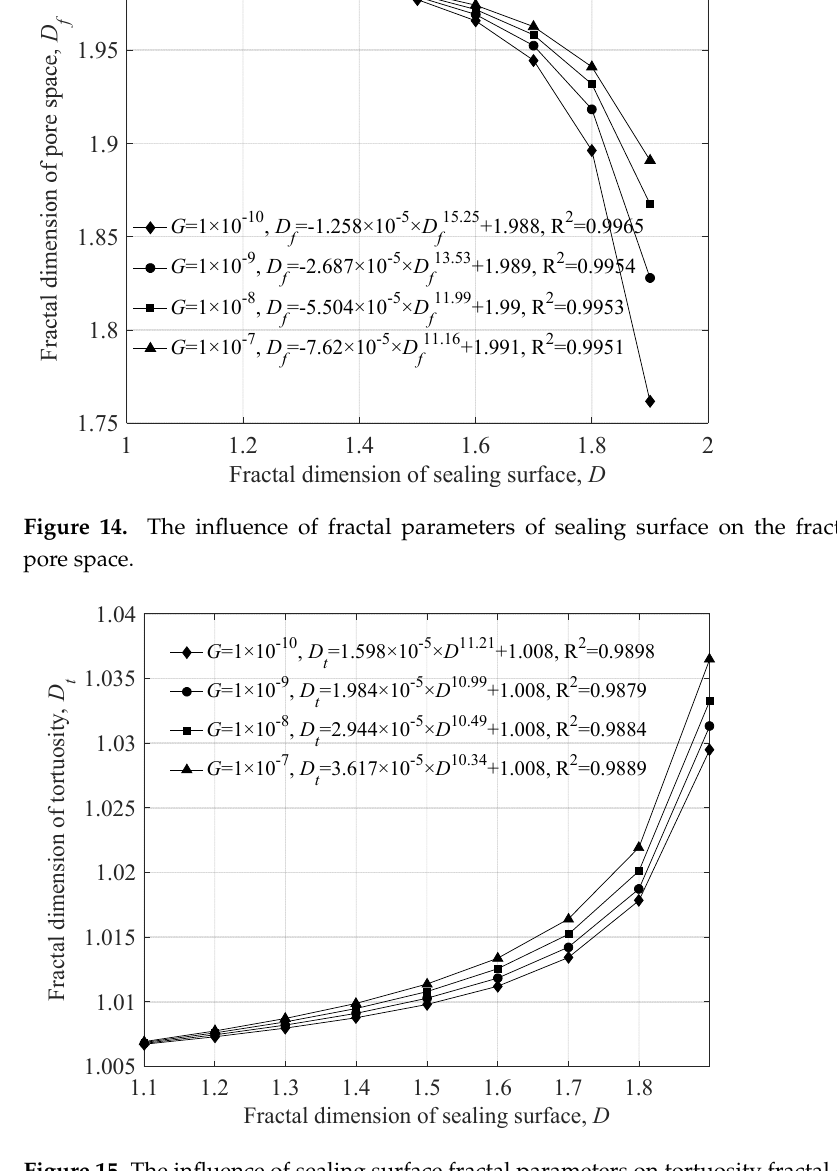
Figure 15 denotes the influence of sealing surface fractal parameters on the value of tortuosity fractal dimension